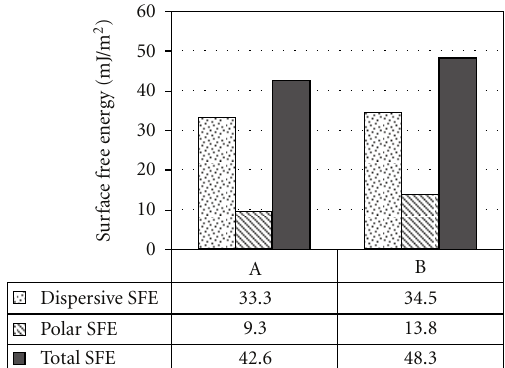
Figure 6: Dispersive ( γ D ), polar ( γ P ), and total ( γ TOT ) components of surface free energy (FRC) calculated using the Owens-Wendt ap- proach: (A) fibers running in-plane (perpendicular) to the camera axis; (B) fibers running in-plane (parallel) to the camera